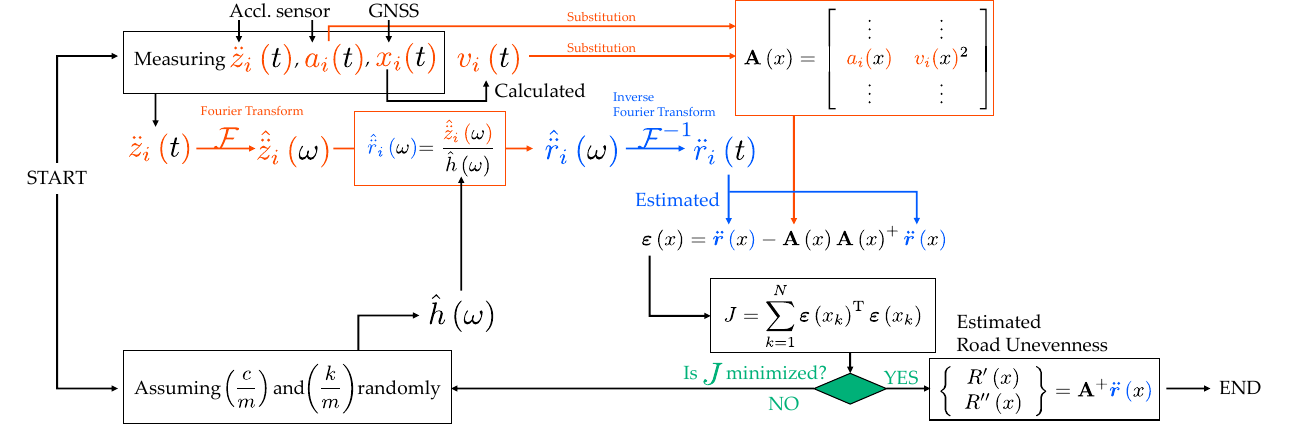
8 of 19 Figure 6. Flowchart of the traditional method of estimating road unevenness, 𝑅(cid:4666)𝑥(cid:4667) , without prior information about the vehicle parameters (cid:4672) (cid:3030) (cid:3040) (cid:4673) and (cid:4672) (cid:3038) (cid:3040) (cid:4673) . The scheme shown above is a simplified version of Xue’s drive-by process, so it is not new. However, as Xue et al. [10] estimate many vehicle parameters simultaneously, searching for the optimal solution in a vast space is necessary. That is the reason why they adopt a GA. However, this method limits the number of vehicle parameters to only two, (cid:4672) (cid:3030) (cid:3040) (cid:4673) and (cid:4672) (cid:3038) (cid:3040) (cid:4673) . Therefore, the computational cost is significantly reduced and it is possible to try all patterns. Note that it is necessary to measure the position information of the